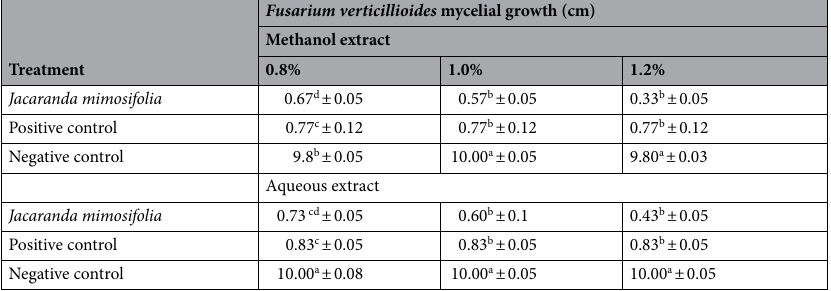
Table 2. Antifungal activity of Jacaranda mimosifolia extracts against Fusarium verticillioides . Data represent mean ± standard deviation (SD) of three replicates . All mean values in the same column with different letters are significantly different from each other (P < 0.05). Positive control: Terbinafine hydrochloride. Negative control for methanolic extracts: DMSO. Negative control for aqueous extracts: sterile distilled water.